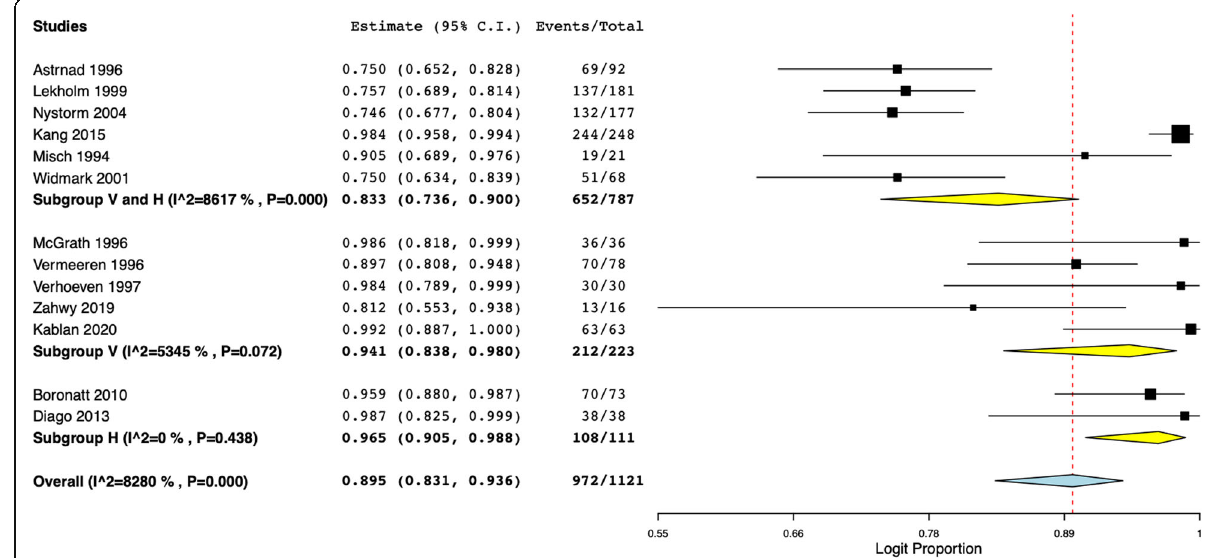
Fig. 5 Meta-analysis of implant survival with sub-group analysis based on type of defect. V, vertical defect; H, horizontal